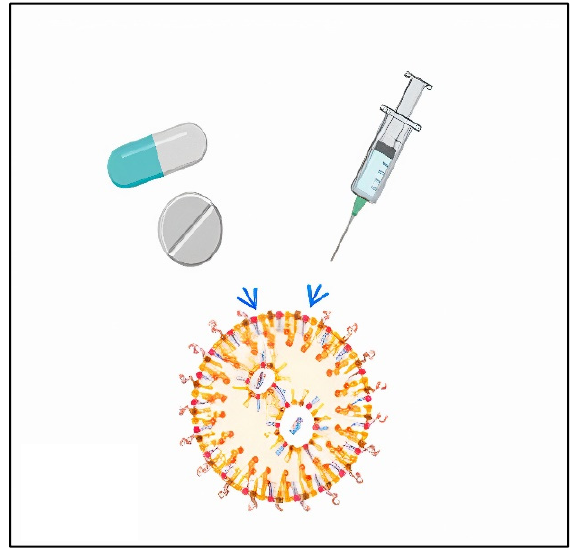
Figure 7. SNPs carrier as drug